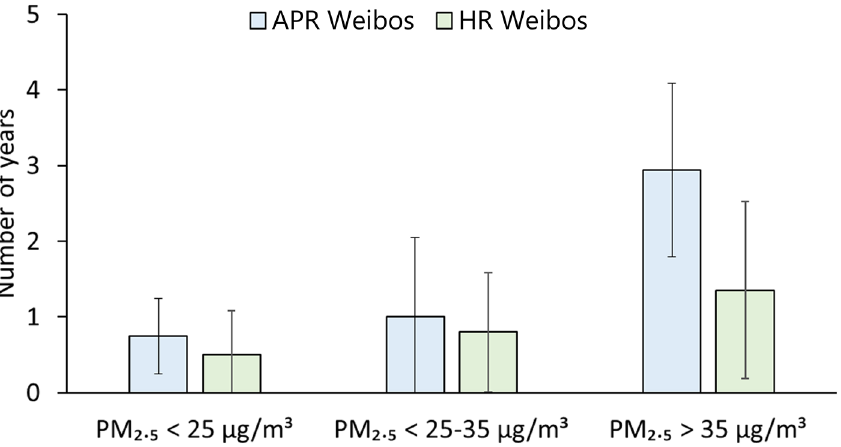
Figure 7. Number of years with significant and positive correlation of PM 2.5 against APR Weibos and HR Weibos for the three groups of